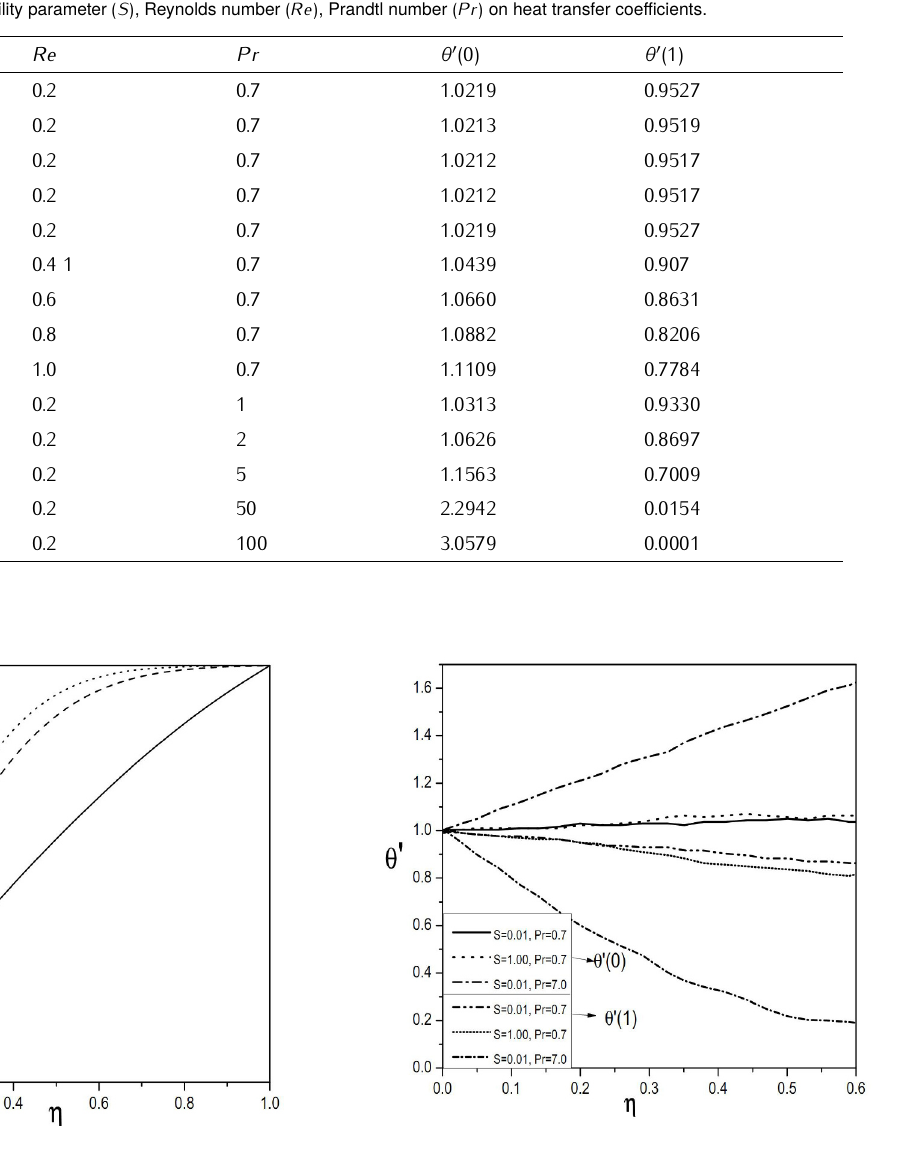
Figure 8. Effect of Prandtl number Pr on temperature profile.